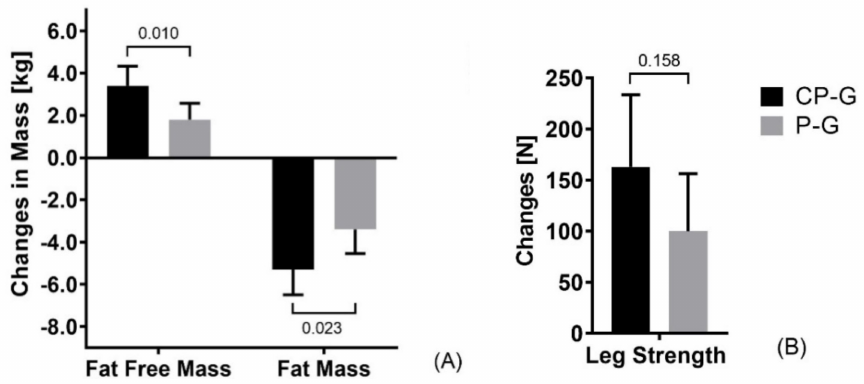
Figure 2. Absolute changes in ( A ) body composition and ( B ) isometric muscle strength at the end of the study compared between groups of the main analysis (CP-G vs. P-G). Data are shown as mean ± 95 % CI; p values <0.05 were considered